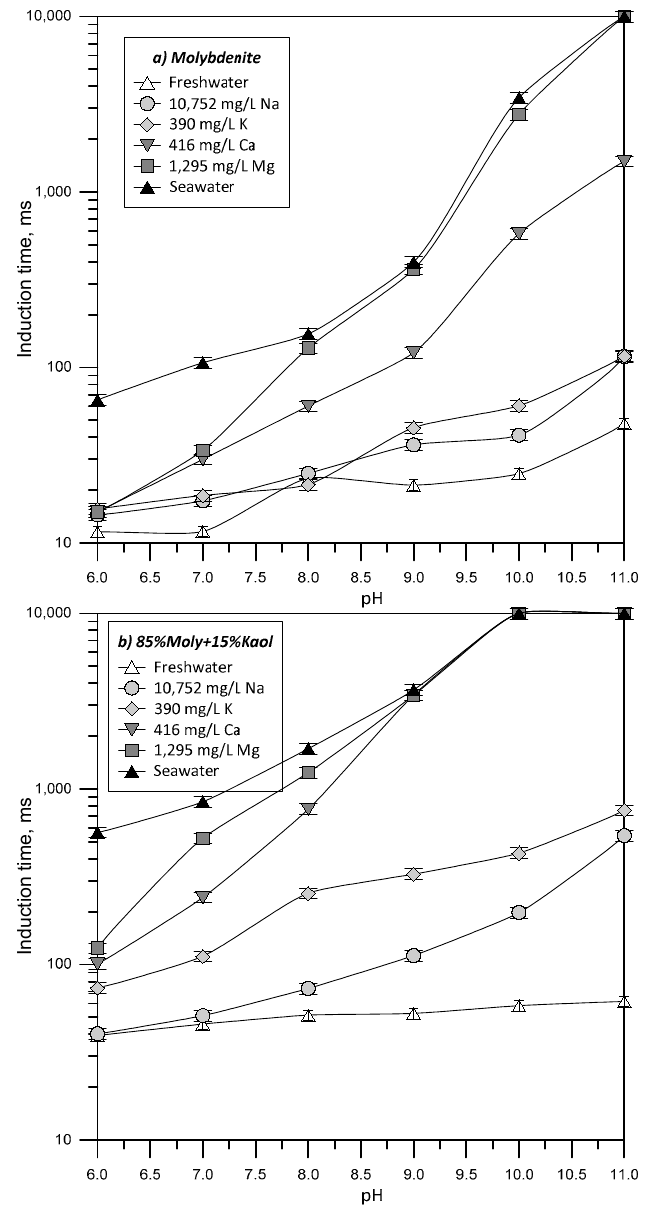
Figure 3. Induction times obtained at different pH in freshwater, seawater and in solutions of 10,752 mg/L Na, 390 mg/L K, 416 mg/L Ca, 1295 mg/L Mg. The measurements were done using particle beds of ( a ) molybdenite and ( b ) 85% molybdenite + 15% kaolinite. Moly: molybdenite; kaol: kaolinite.